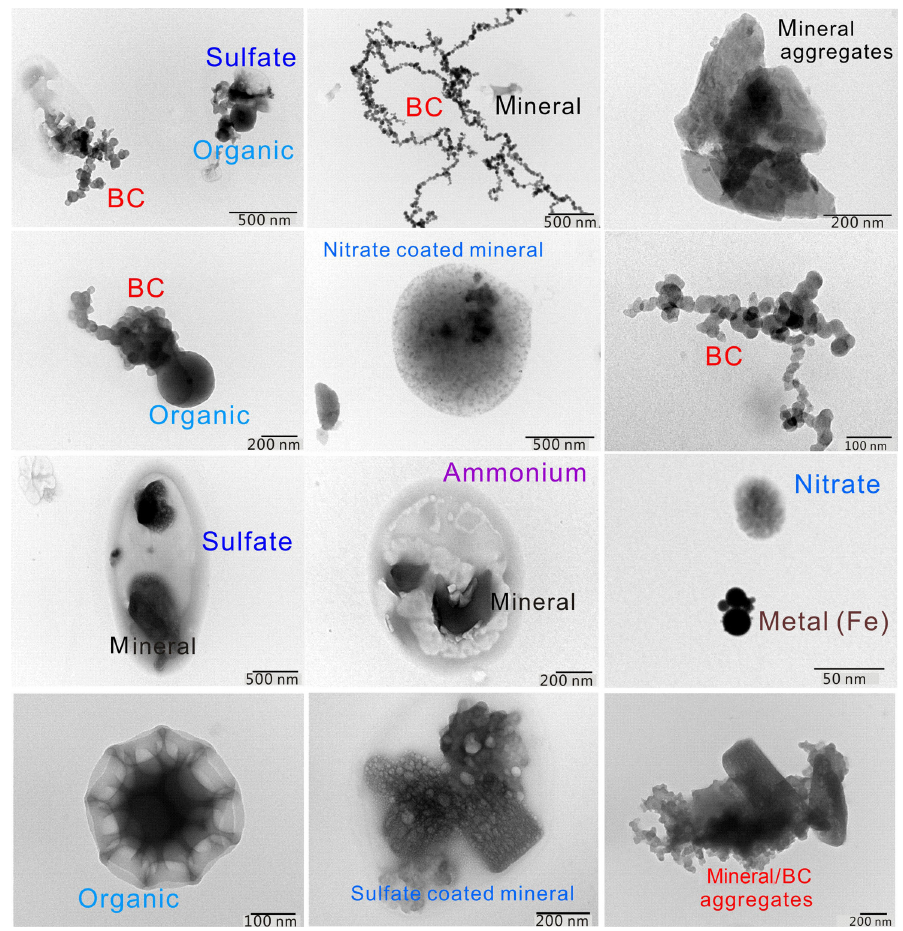
Figure 2. Component types of individual LAP particles in the glaciers and snowpack of the northeastern Tibetan Plateau. Based on the above TEM microscope observation, aerosols were classified into seven type components: NaCl salt, mineral dust, fly ash, black carbon (soot), sulfates, nitrates, and organic